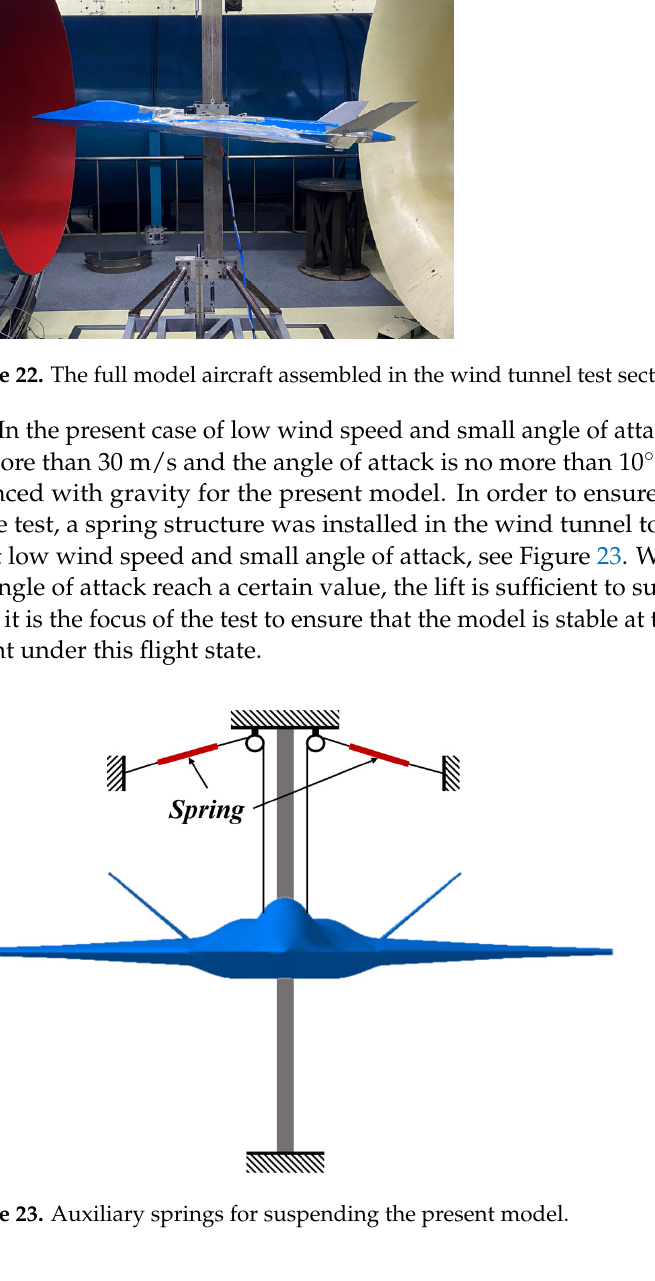
Figure 21. Simulation results of the flight control law: ( a ) the height result by Simulink; ( b ) the height result by semi-physical simulation; ( c ) the pitch angle result by Simulink; and ( d ) the pitch angle result by semi-physical simulation.